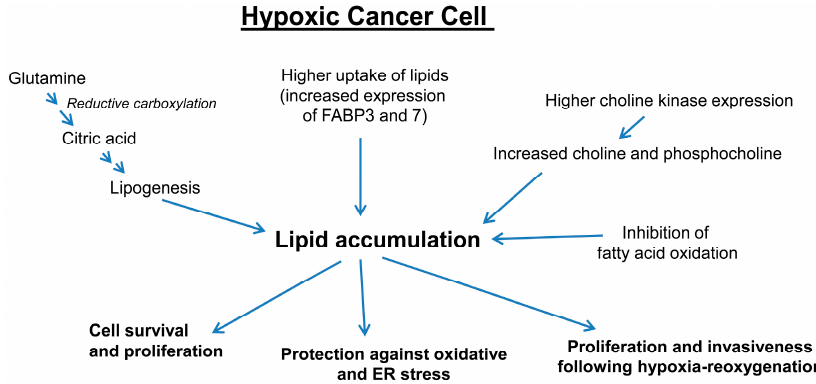
Figure 3. Convergent metabolic pathways in a hypoxic microenvironment; In hypoxic PCa cells, multiple pathways lead to the accumulation of lipids, which play key role in cell survival, protection against stress and proliferation especially following re-oxygenation after hypoxia. FABP, fatty acid binding protein.